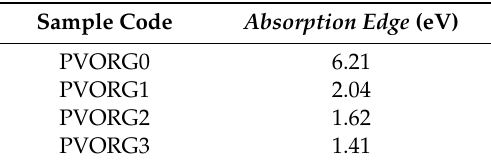
Table 1. Absorption edge values for pure PVA (PVORG0) and PVA composite